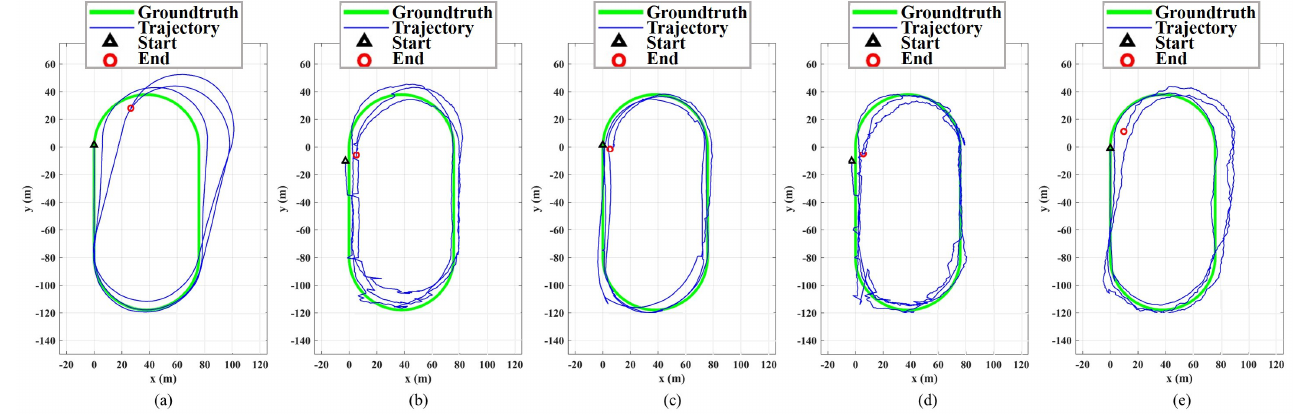
Figure 9. Results of three-lap GNSS/PDR fusion test of five pedestrian positioning methods. ( a ) Only PDR trajectory. ( b ) Only RTD trajectory. ( c ) The trajectory of the proposed method. ( d ) MREKF trajectory. ( e ) ESC trajectory.